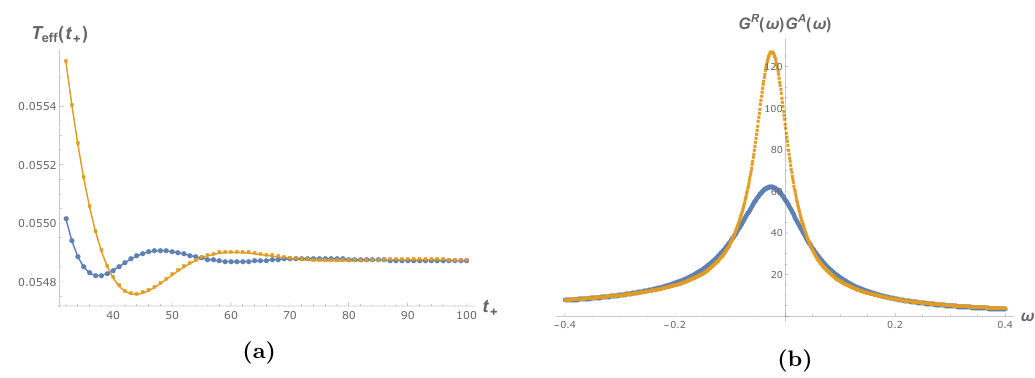
Figure 5. (a) The effective temperature as a function of t + calculated using different frequency cutoffs. This is for the quench for µ = − 0 . 263 starting from β i = 40 , η = 0 . The final state is β f = 18 . 24 , η = − 0 . 029 . Note that the chemical potential changes during quench. (b) Considering the same quench, the spectral asymmetry frequency ω s does not change during quantum quenches with SYK interactions. In this case, ω s = − 0 . 025 . The blue dots are G R ( ω ) G A ( ω ) before quench and the orange dots are G R ( ω ) G A ( ω ) after quench.